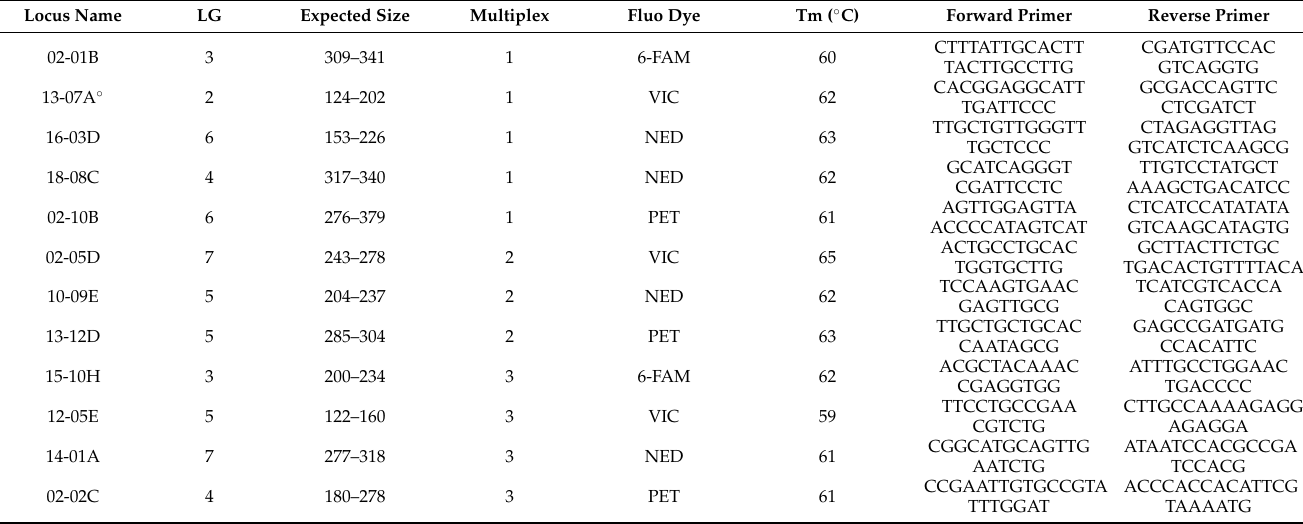
Table 2. Sequences (5 (cid:48) to 3 (cid:48) ) of the primer pairs used to amplify the SSR markers. For each primer pair, locus name, linkage group membership, maximum and minimum amplicon size (bp), multiplex to which the SSR marker locus belongs, fluorescent dye used, and temperature of